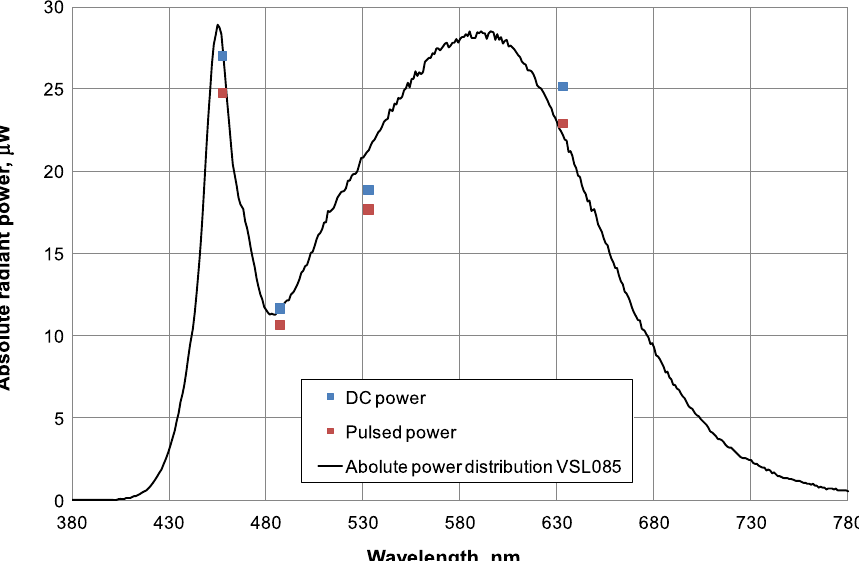
Fig. 11. Resulting absolute power of the short-pulse driven (red) and DC-driven (blue) DUT VSL085 at ODS fi lters wavelengths; the scaled spectral distribution function is given for the reference in